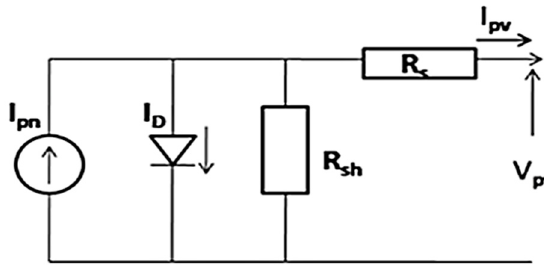
Figure 2. The equivalent electrical circuit of the PV cell.